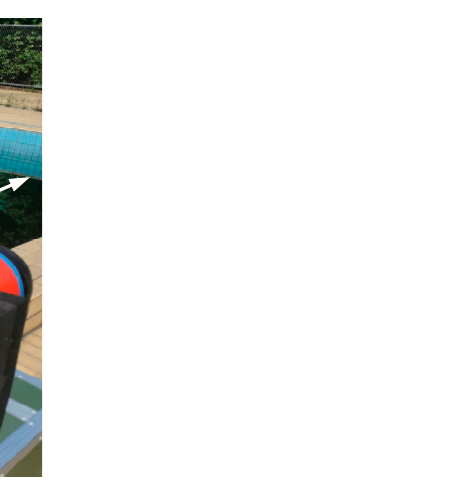
There is a 90-degree phase difference between the induced voltage and the magnetic field intensity in the coil. The equivalent circuit of the coil and signal-processing circuit is shown in Figure 5. L r , R r and C r are the inductance, internal resistance, and internal capacitance of the coil, respectively [15,19]. The subsequent signal-processing circuit is regarded as an amplifica- tion with a gain of A , and its impedance can be considered very large. The signal detected by the ADC is: